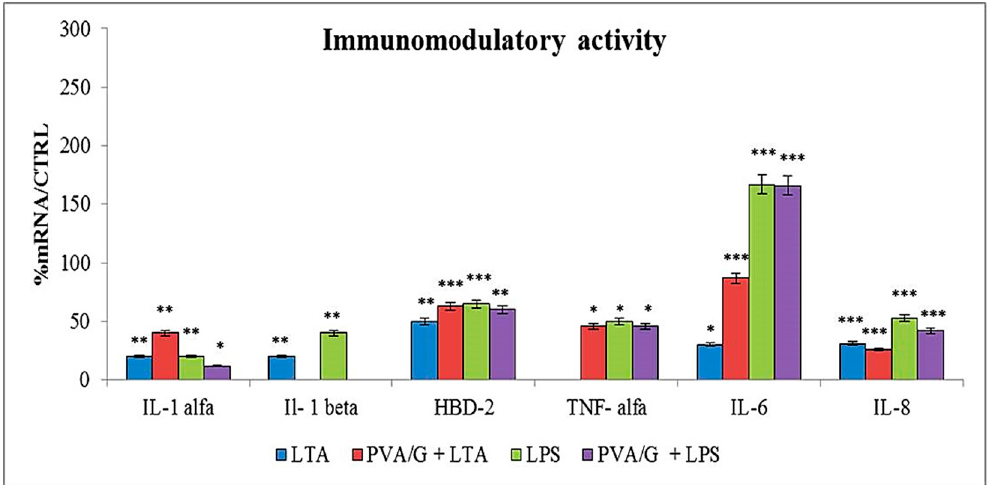
Figure 7. Bar graph reporting the RT-PCR results related to the HaCaT cell response to PVA/G scaffold. mRNA expression was normalized for the basal expression of untreated HaCaT cells. PVA/G = Poly(vinyl alcohol)/Gelatin; LTA = lipoteichoic acid; LPS = lipopolysaccharide; IL = interleukin; TNF = tumor necrosis factor; HBD-2 = human beta defensin 2. Data are expressed as mean ± SD versus cells cultured without biomaterials; * p < 0.05; ** p < 0.01; *** p < 0.001.